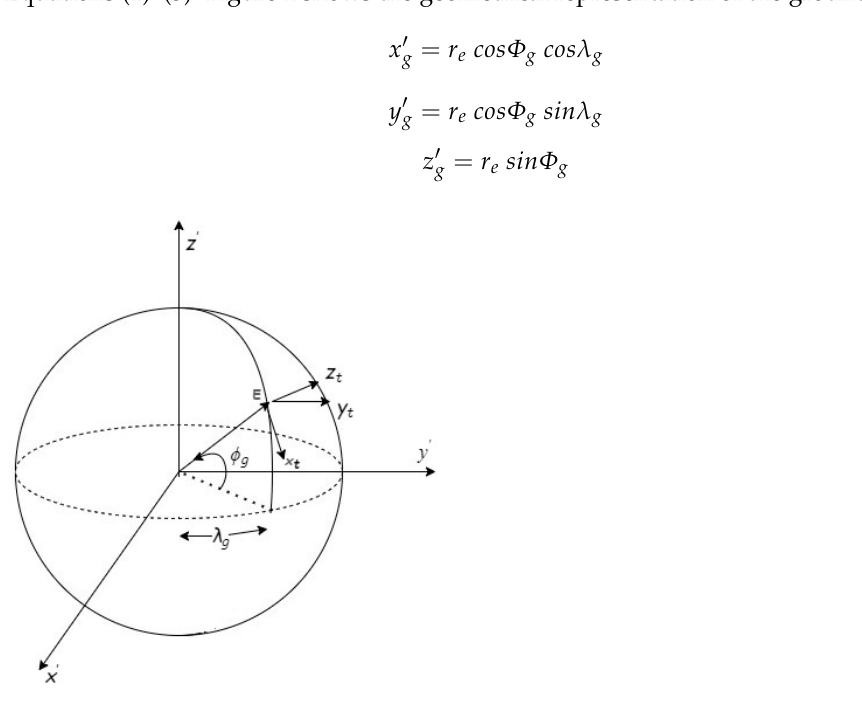
Figure 2. Cartesian coordinates geometry diagram of ground observer.